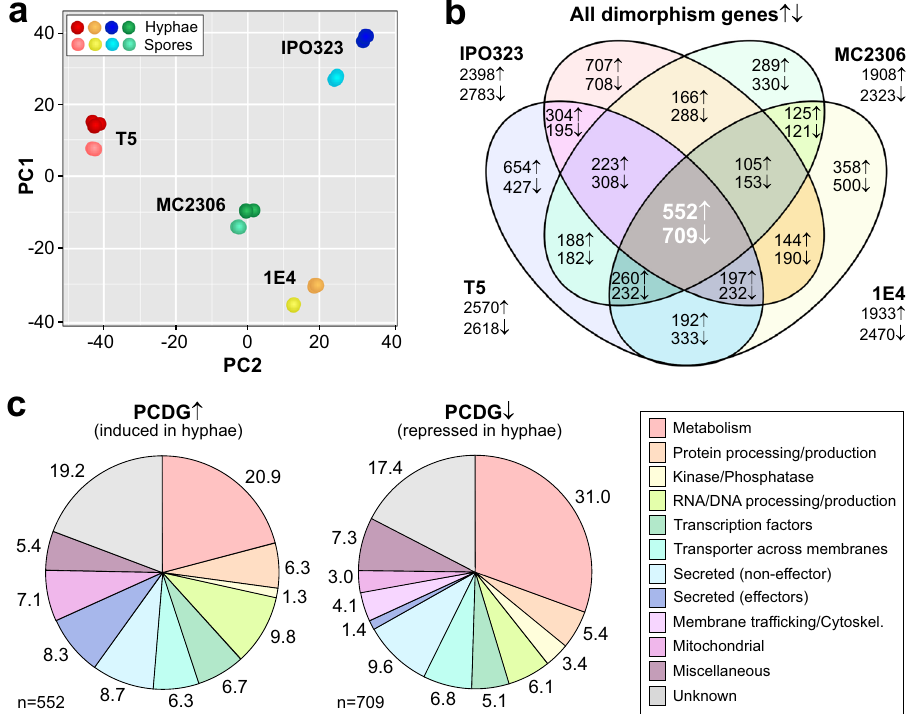
Fig. 4 | Comparison of gene expression in spores and hyphae of four wildtype strains. a Principal component analysis of transcriptomes (indicated by dots) in wildtypestrainsIPO323,MC2306,1E4andT5.Cellsweregrownfor2 – 3daysinMMat 18°C/WLSE (darker symbols) or 12°C/MetOH (light symbols). Clustering indicates similarityamongstdatasets.Numberofexperiments:3(MC2306)or4(IPO323,1E4, T5). Note the diverse transcriptional pro fi les of the strains. See Supplementary Data 2. b Venn diagram showing number of genes, signi fi cantly ( P <0.01) upregu- lated ( ↑ ) or downregulated ( ↓ ) in hyphae of strains IPO323, MC2306, 1E4 and T5,